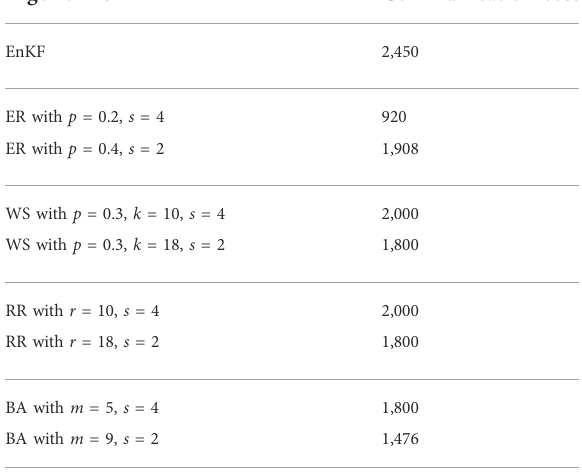
TABLE 1 The communication cost of EnKF and our method with different communication round s for some networks. Algorithms